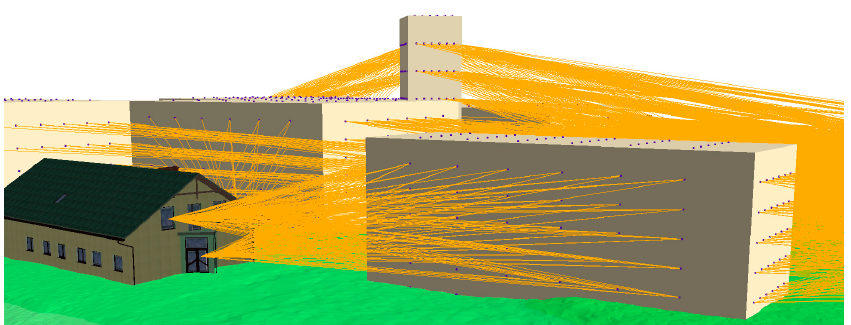
Figure 7. Visible value sightlines. Source: own work.